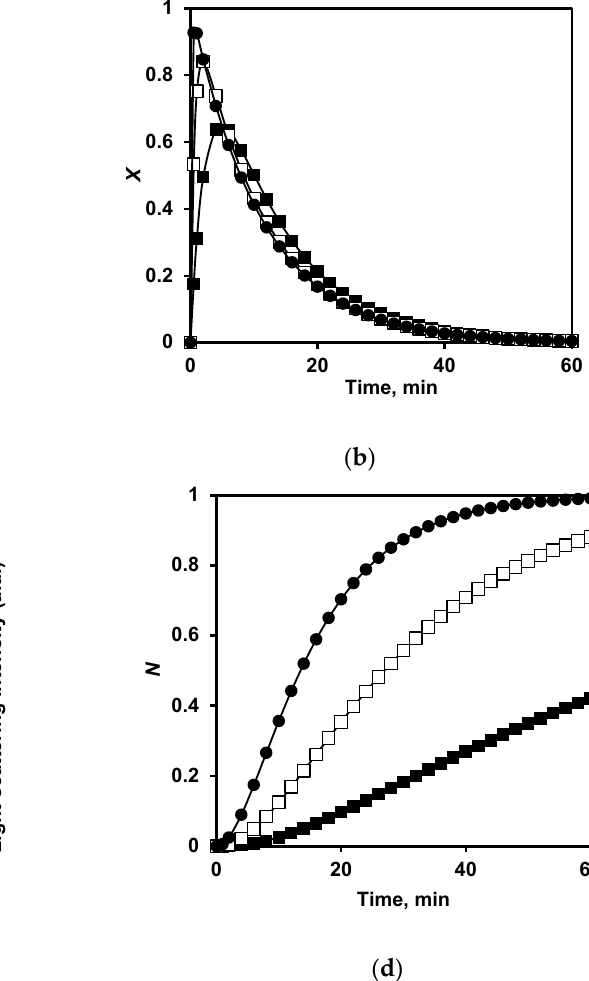
Figure 8. Calculated time dependences for functions ( a ) S ( t ), ( b ) X ( t ), ( c ) Y ( t ), and ( d ) N ( t ) for proteolysis processes at different enzyme concentrations: E 0 = 0.25 mg/L, S 0 / E 0 = 1000 ( ■ ); E 0 = 1 mg/L, S 0 / E 0 = 250 ( □ ); and E 0 = 4 mg/L, S 0 / E 0 = 63 ( ● ). ( c ) Experimental points for light-scattering data ( ● , red) at E 0 = 0.25 mg/L and S 0 / E 0 = 1000.